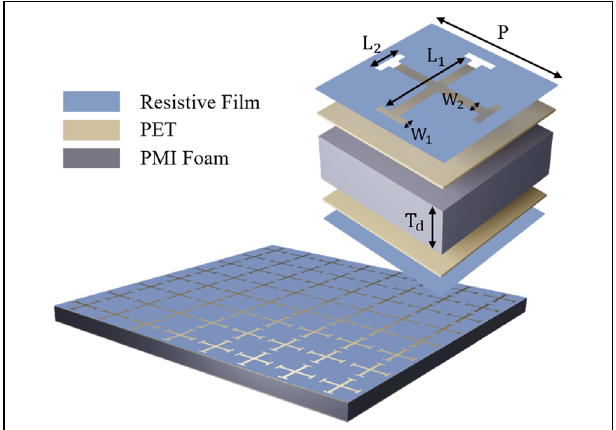
FIGURE 1 | Schematic diagram of the Jerusalem cross absorber.